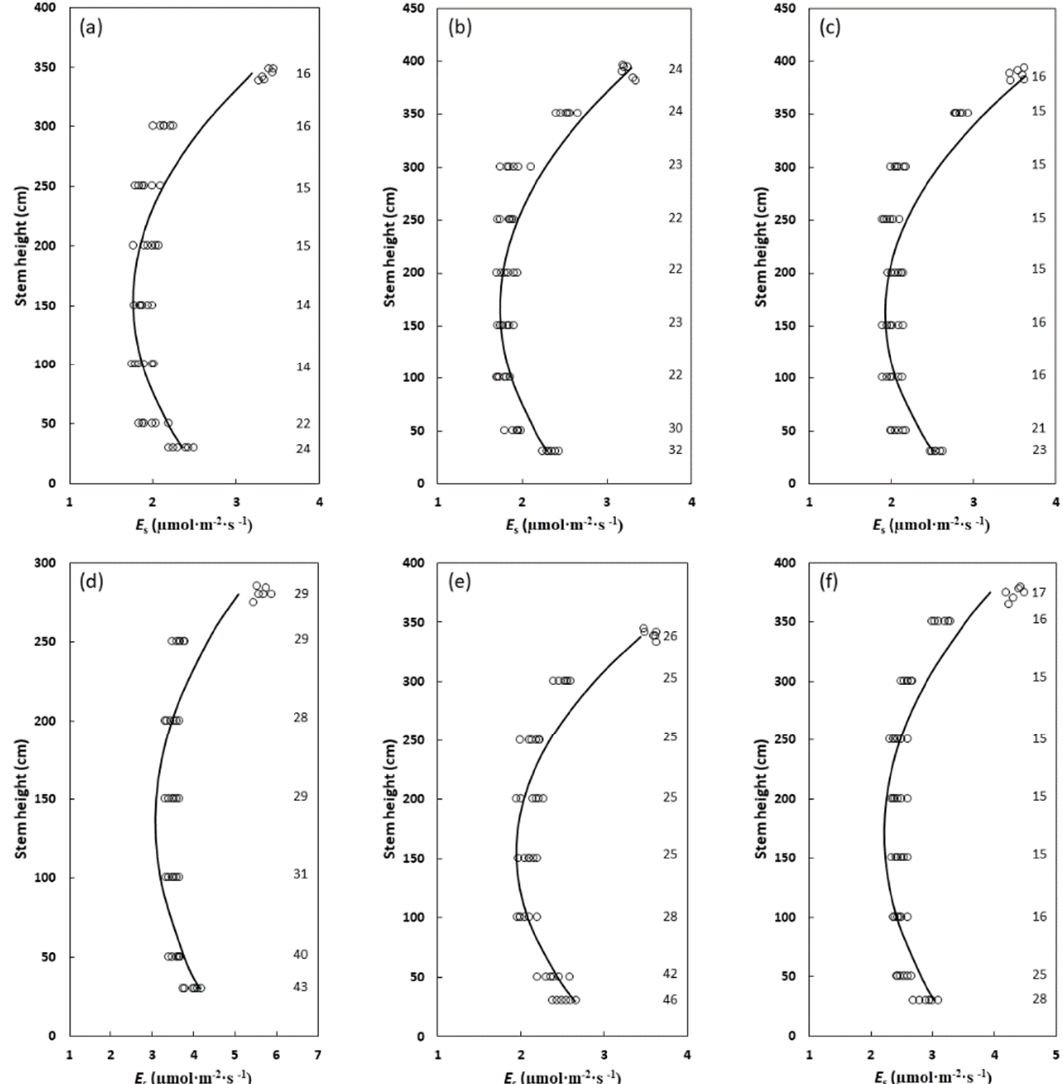
Figure 2. The relationship between vertical strata and stem carbon dioxide e ffl ux ( E s ) for six arborescent Cycas species. ( a ) Cycas edentata ; ( b ) Cycas micronesica ; ( c ) Cycas nitida ; ( d ) Cycas revoluta ; ( e ) Cycas wadei ; and ( f ) Cycas zambalensis . Solid lines represent the quadratic model calculated from the mean of each parameter after fitting the data for each of the six replications per species, with axes transposed. Numbers on the right vertical axis represent the mean stem diameter for the six replications of each species. Models for each species were: ( a ) E s = 2.63 − 0.01*height + 0.00004*height 2 ; P < 0.001; R 2 = 0.78; ( b ) E s = 2.54 − 0.01*height + 0.00003*height 2 ; P < 0.001; R 2 = 0.88; ( c ) E s = 2.77 − 0.01*height